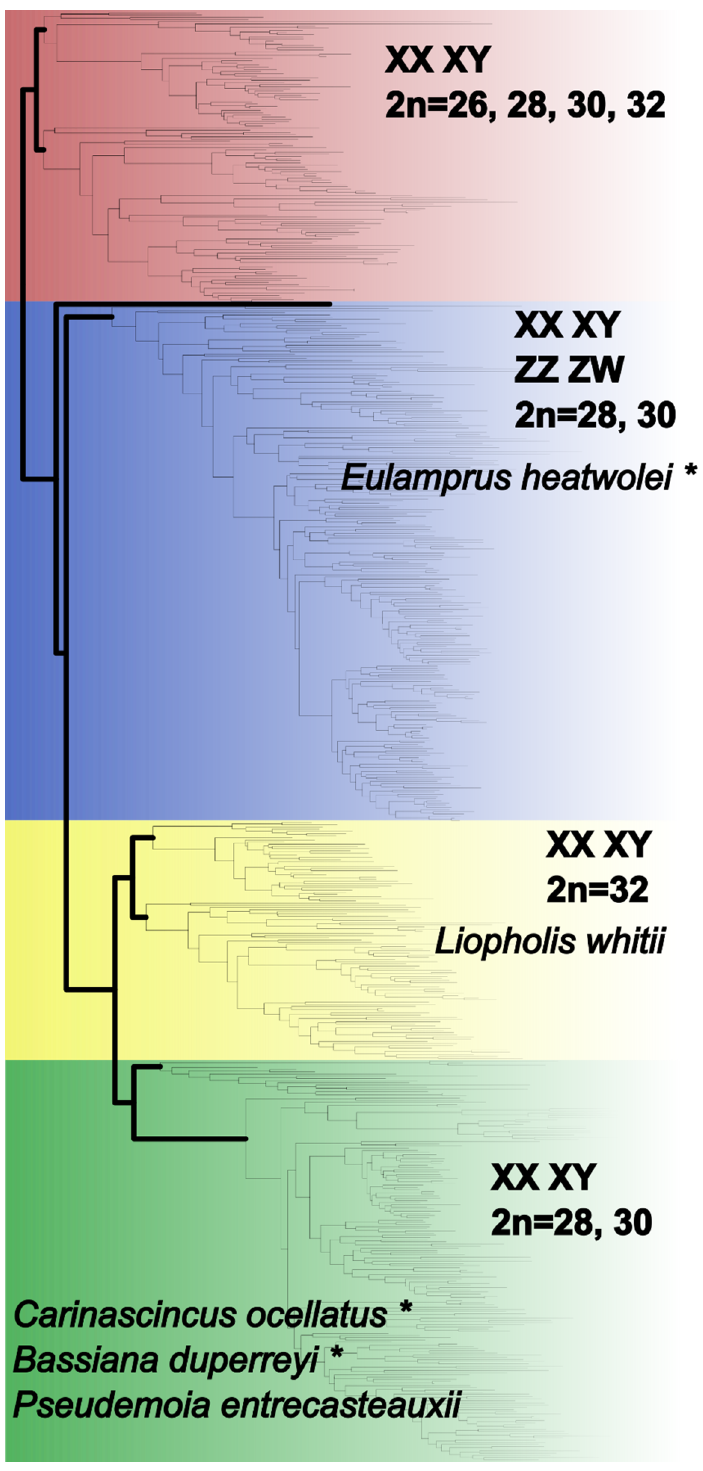
Figure 1. Variation in diploid chromosome complement and sex determination in Scincid subfamilies Scincinae (red) and Lygosominae (blue, yellow and green). The clades to which our study species ( Carinascincus ocellatus and Liopholis whitii ) belong and other species of interest discussed herein are included. The age of the split between clades containing C. ocellatus , L. whitii and E. heatwolei is estimated as 79 mya [56]. Adapted from Pyron , et al. [59] and Olmo and Signorino [43]. * denotes species where thermosensitive sex determination has been reported [35,45,46,49].